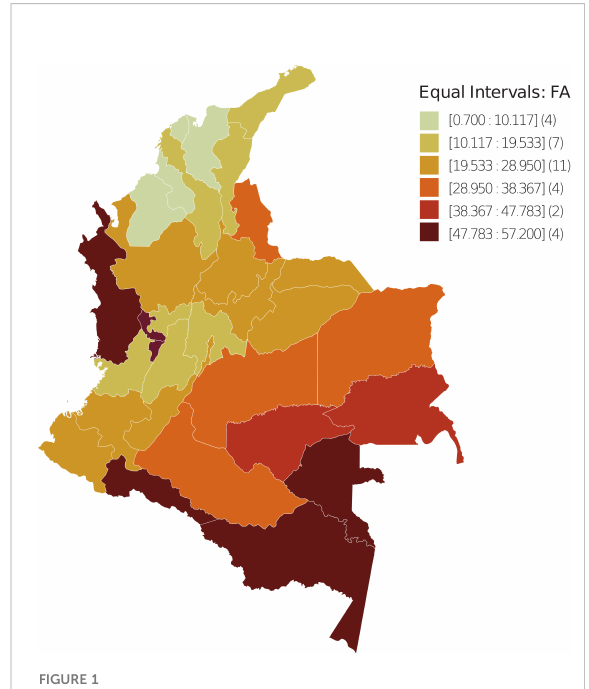
FIGURE 1 Spatial dispersion of the FA index in Colombia - 2018. The spatial units were divided into six uniform intervals in terms of FA values. Between parentheses is the number of spatial units with FA value in the corresponding interval.